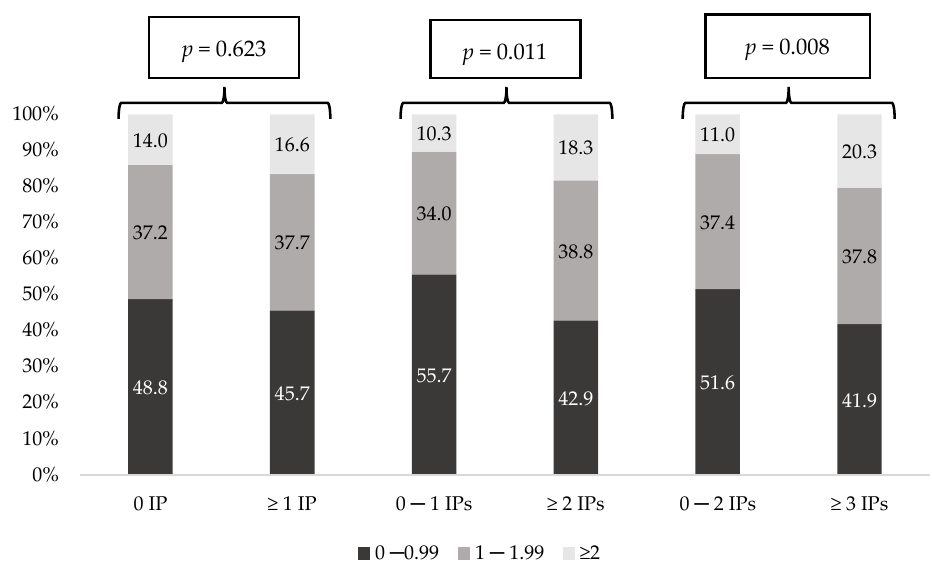
Figure 5. Prevalence of DBI degree considering the number of Inappropriate Prescriptions (IPs).